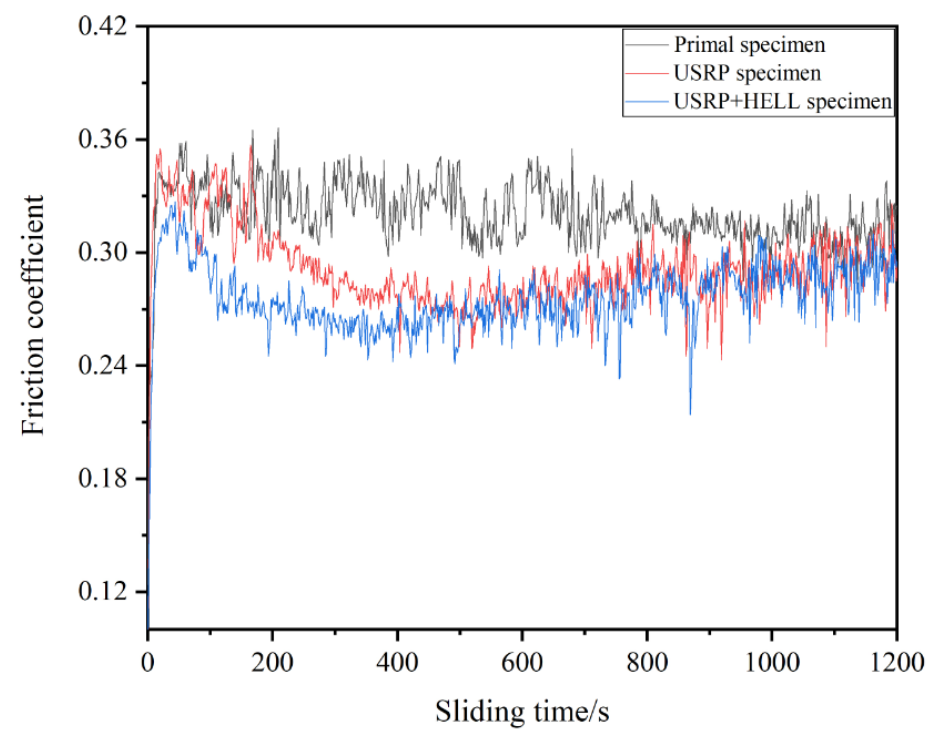
Figure 3. Variation curve of the friction coefficient of different samples. The amount of wear directly reflects the wear resistance of the material. Thickness, mass, and volume are three ways to characterize the wear amount. The wear resistance was evaluated by measuring the volume wear of the samples treated with different processes. The volume wear of the samples with the three treatments is shown in Figure 4. The figure shows that the volume wear of the samples treated by ultrasonic rolling was significantly smaller than the original magnesium alloy under the same experimental conditions. The volume wear of the composite-treated samples was the smallest and was related to the friction coefficient. The performance was consistent, thus indicating that the ultrasonic- rolling process can significantly improve the wear resistance of magnesium alloy materials. The wear resistance of the materials treated by the USRP + HELL composite process was further improved, which proves that ion-implantation technology based on prefabricated nanostructured layers is an effective method to improve the friction and wear properties of magnesium alloys. Figure 5 shows the SEM morphology of the wear track. The morphology of sample S1 showed obvious grooves and pits, the plastic deformation was serious, and a large amount of wear-scar debris appeared on the surface of the wear scar, indicating that the polished magnesium alloy sample had adhesive wear and abrasive particles, which is the main wear mechanism of magnesium alloys. Compared with sample S1, the